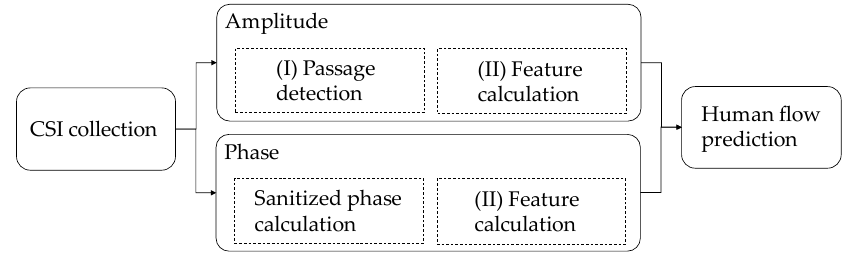
Figure 2. Overview of the proposed system.